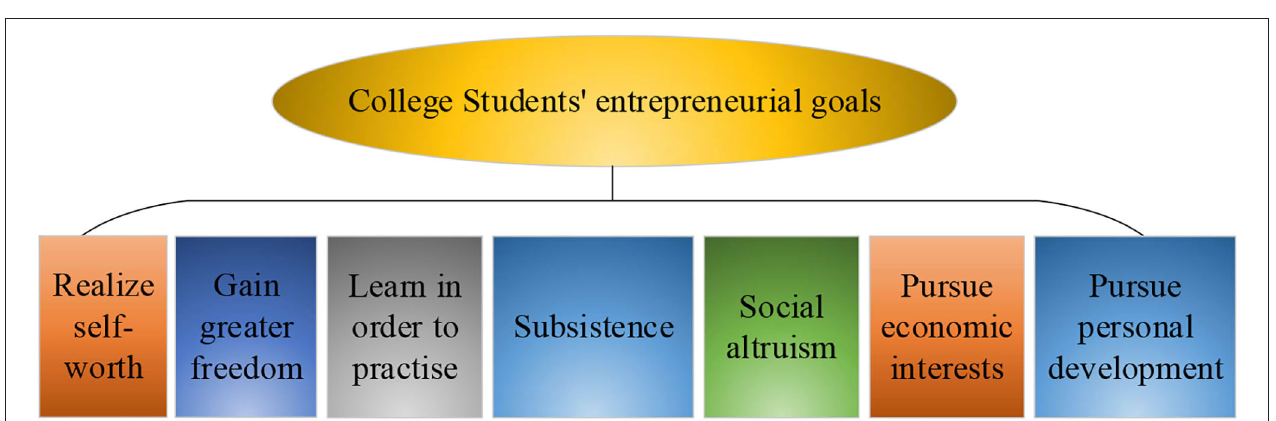
FIGURE 2 | Operation mode of innovative entrepreneurship.